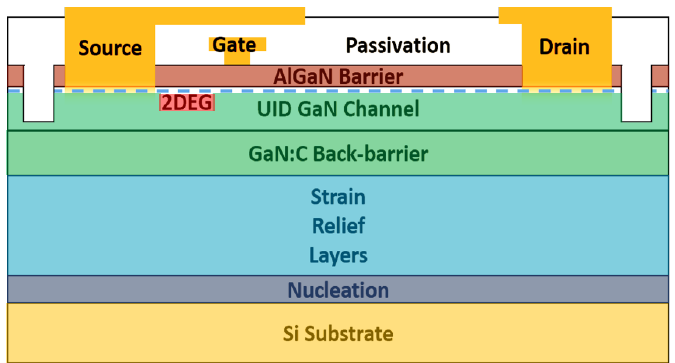
Figure 16. Typical lateral AlGaN/GaN HEMT structure. Reproduce from IOP science under the terms of the Creative Commons Attribution 3.0 license [36].